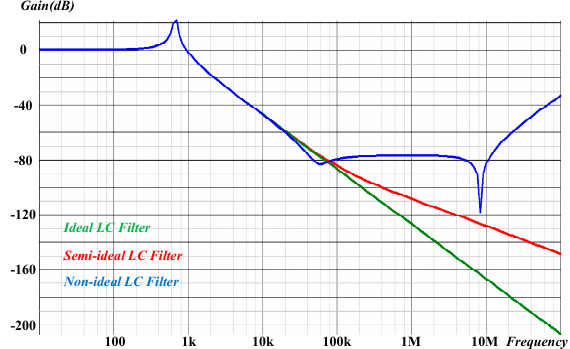
Figure 3. Bode plots of ideal and non-ideal filters.